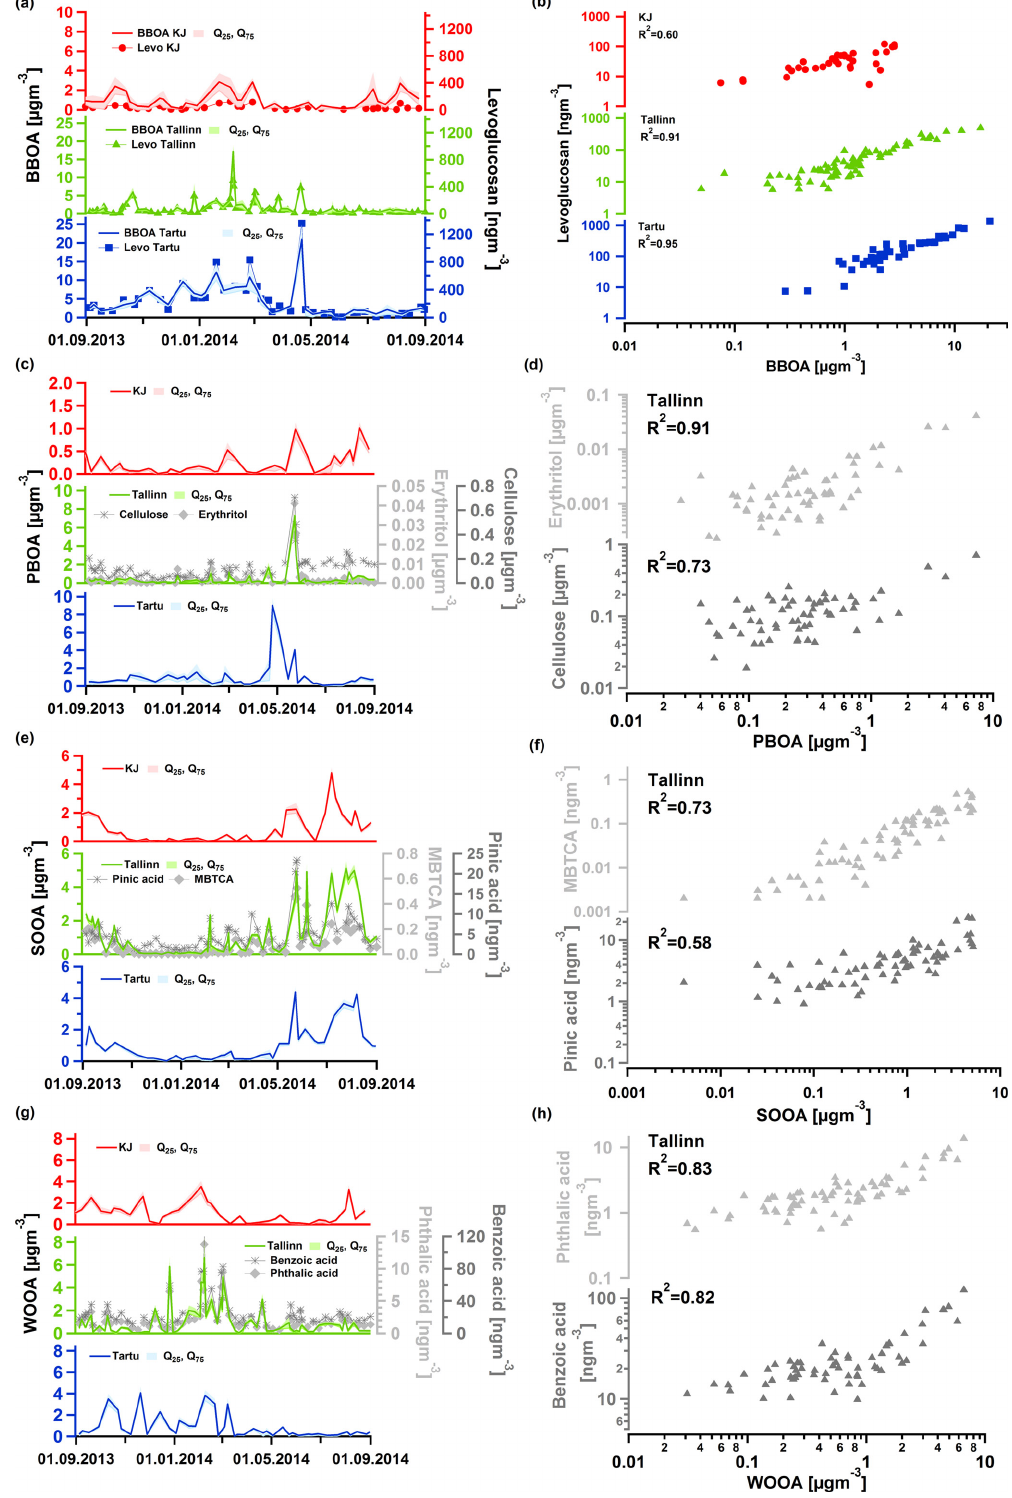
Figure 9. Factor median and external marker concentration time series for all three sites: (a) BOOA and levoglucosan (note the change of the scale for KJ); (c) PBOA, cellulose and erythritol (note the change of the scale for KJ); (e) SOOA, pinic acid and MBTCA; and (g) WOOA, benzoic and phthalic acid, with the respective scatterplots between factors and external markers in (b) , (d) , (f) and (h) . The colors red, green and blue denote the site (KJ, Tallinn and Tartu), and the markers in light and dark grey denote the concentrations of the external markers. The shaded areas represent the first ( Q 25 ) and third ( Q 75 )